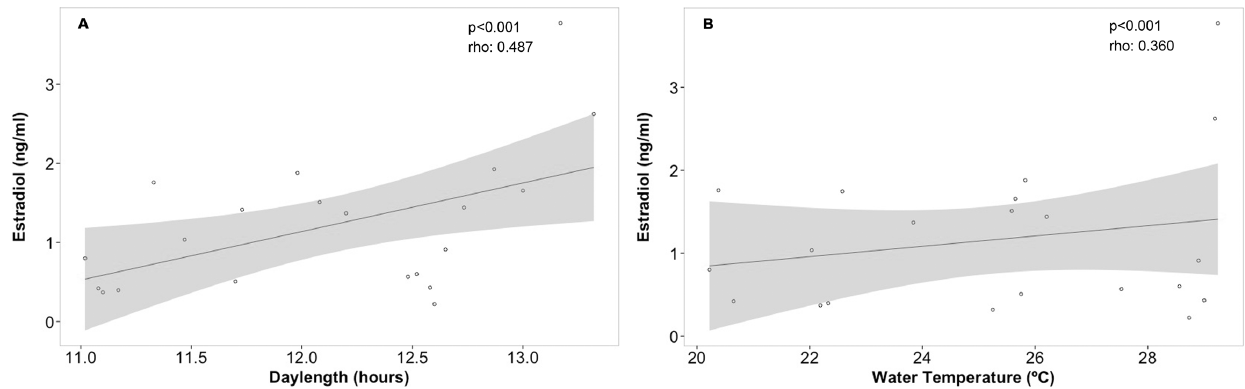
Figure 6. Seasonal changes in 17 b -estradiol levels in Rhizoprionodon taylori were positively correlated with changes in environmental parameters: (A) day length and (B) water temperature. Graphs show the correlation, including regression line and confidence interval of 95% represented by the shaded area.